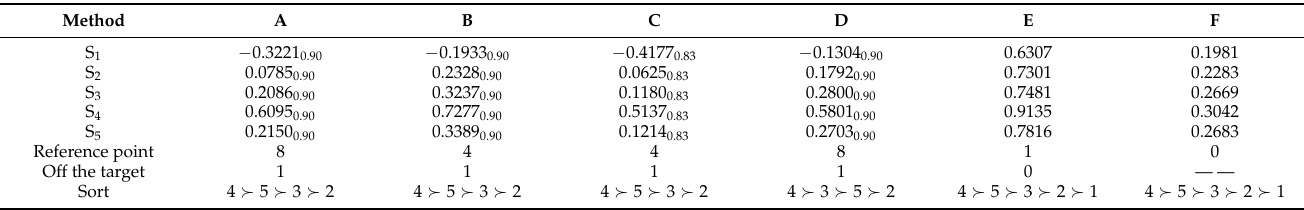
Table 8. Comparison of different methods (comprehensive